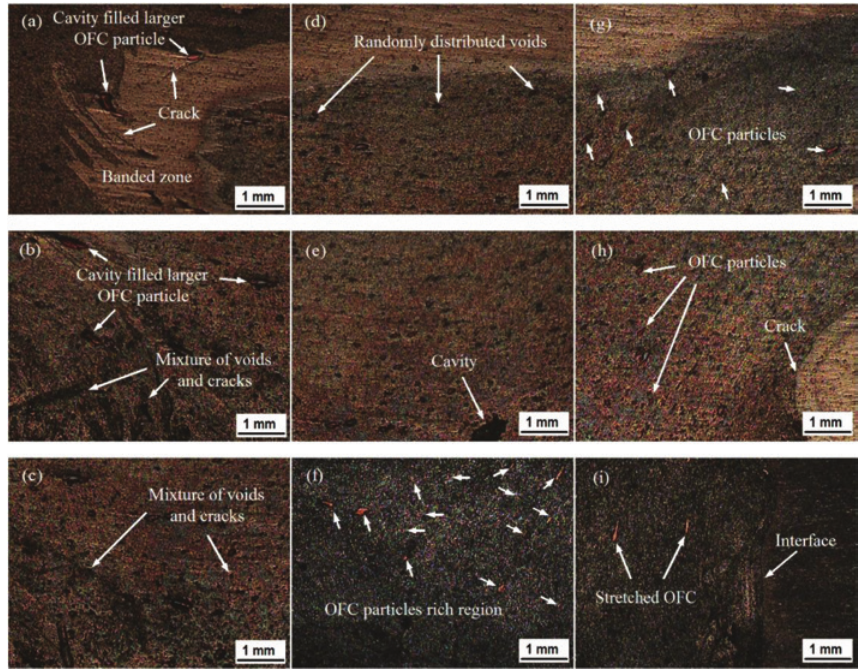
Figure 6: Optical microscope images taken from the cross section of different areas in dissimilar metal butt joints at a rotation speed of 1720 rpm. (a) to (i) Indicates sampling locations as shown in Figure 3.